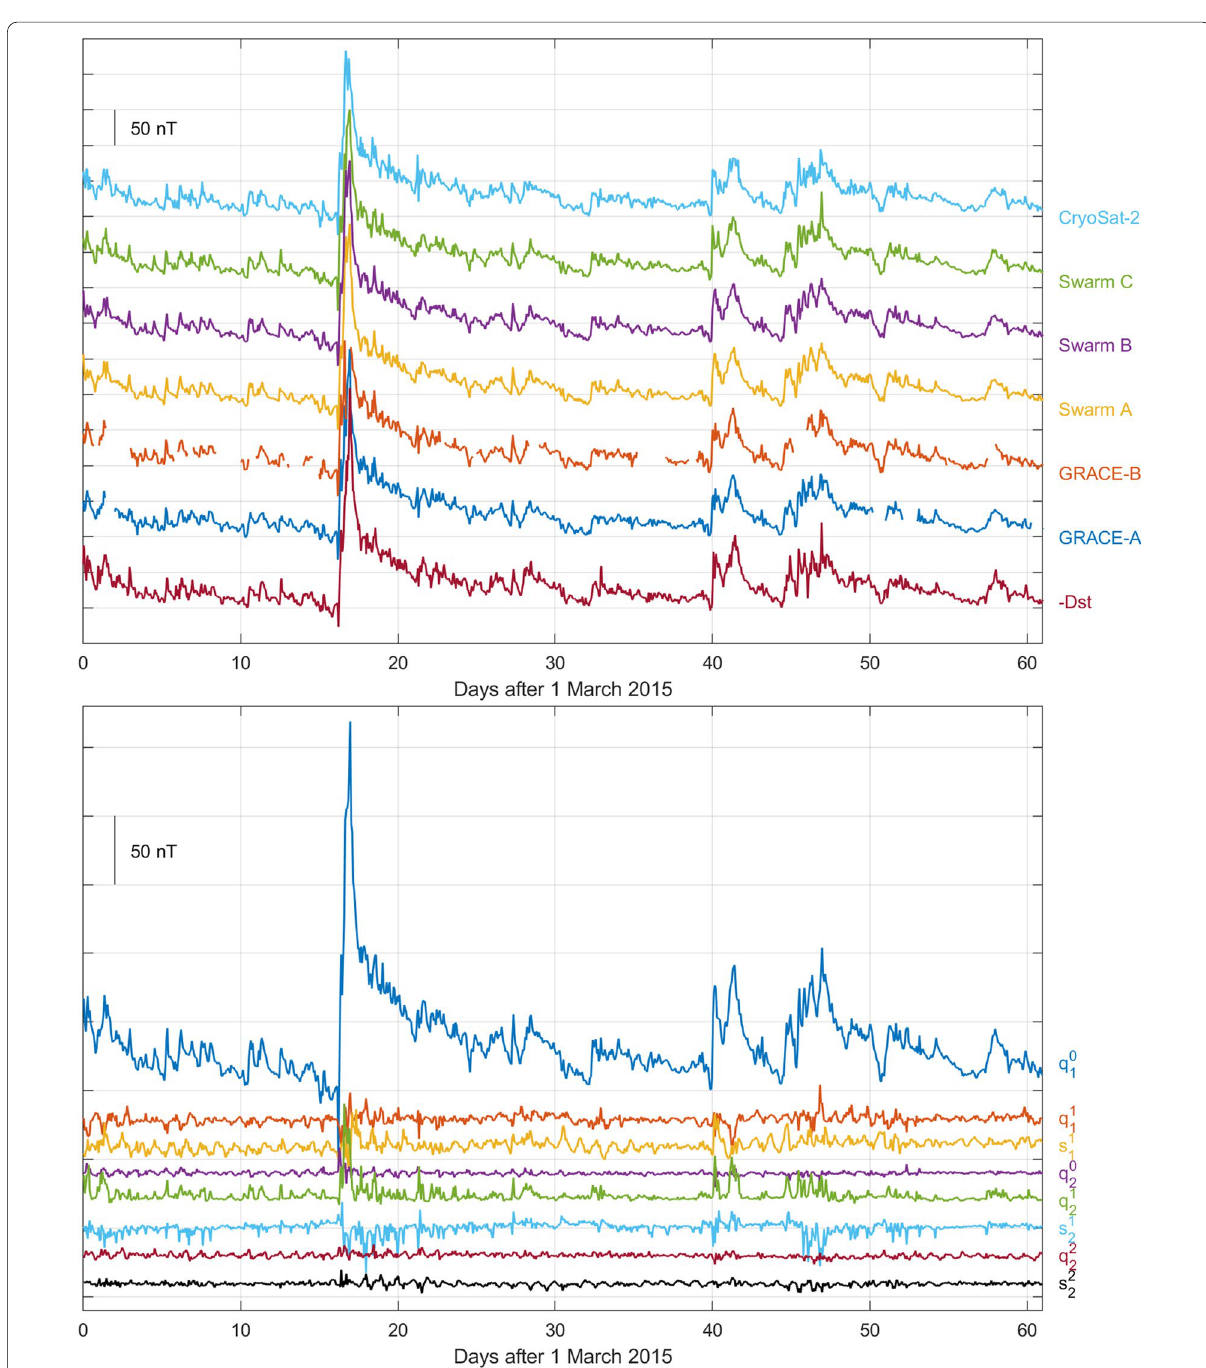
Fig. 11 Top: time evolution of q 0 1 ( t ) describing the strength of the symmetric ring-current as determined separately from magnetic observations of six satellites. Bottom: time evolution of spherical harmonic expansion coefficients up to degree N